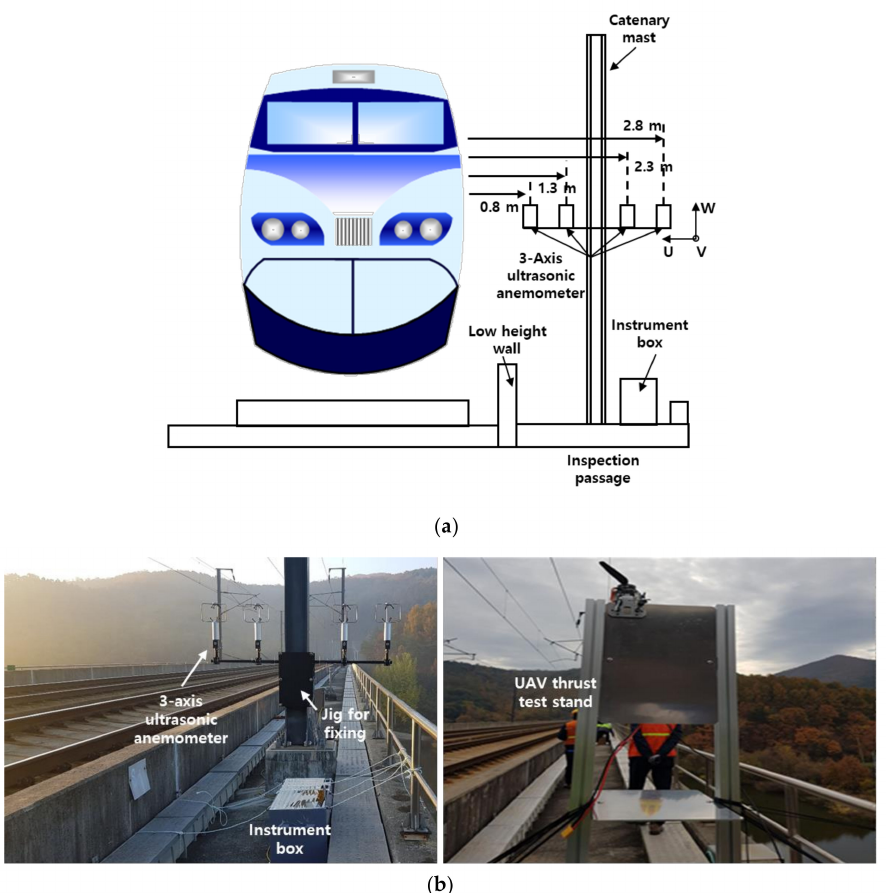
Figure 2. Installation locations of the 3-axis ultrasonic anemometers and UAV thrust measurement system. ( a ) Distances between the 3-axis ultrasonic anemometers and the train. ( b ) Installed train-induced wind and UAV thrust measurement